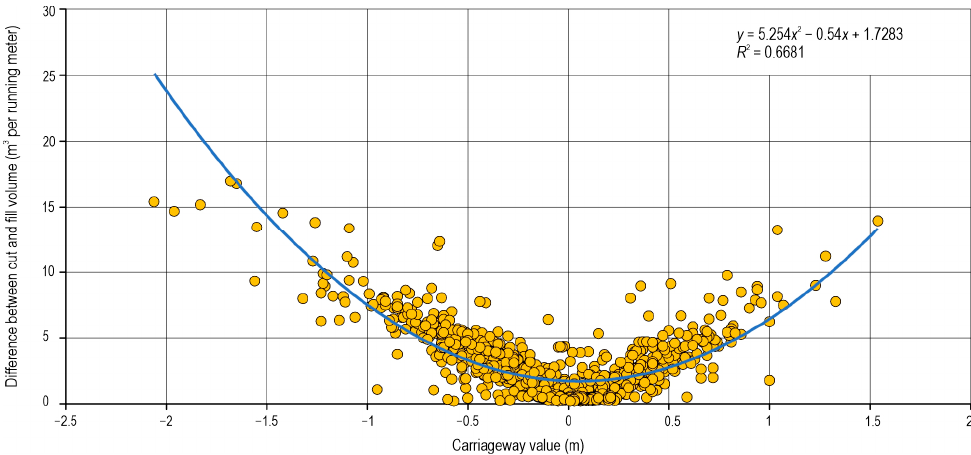
Figure 8. Impact of carriageway value on difference between cut and fill